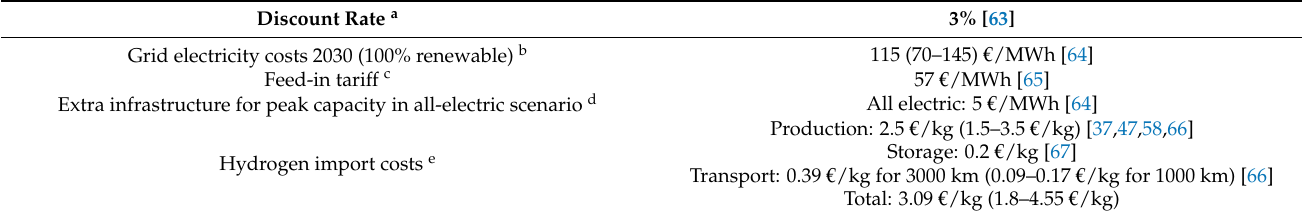
Table 3. Other relevant economic